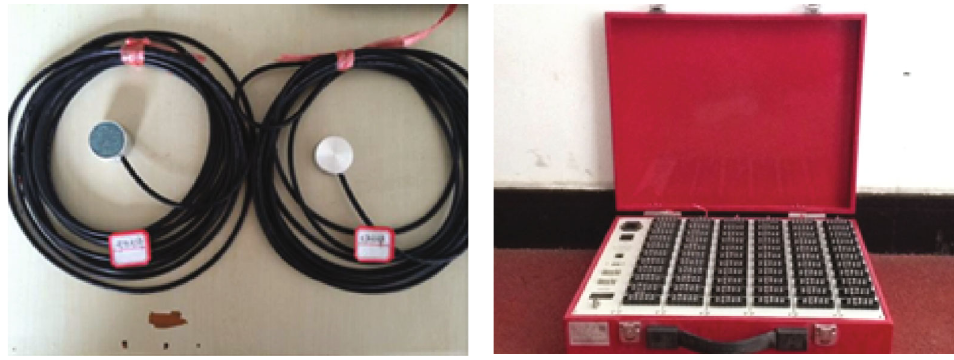
Figure 4: Pressure monitoring